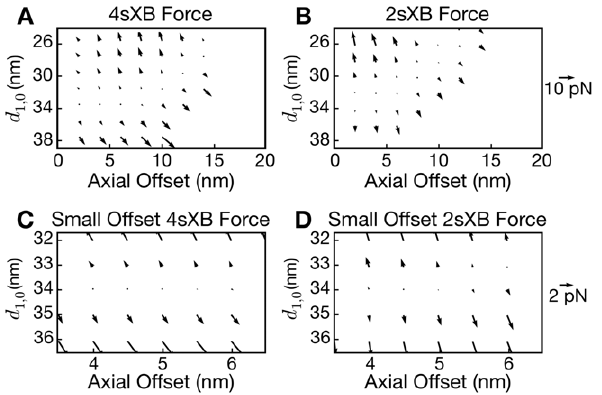
Figure 4. Overview and detail of the forces exerted by the 2sXB and 4sXB models in the post-power stroke state. (A)–(D) show